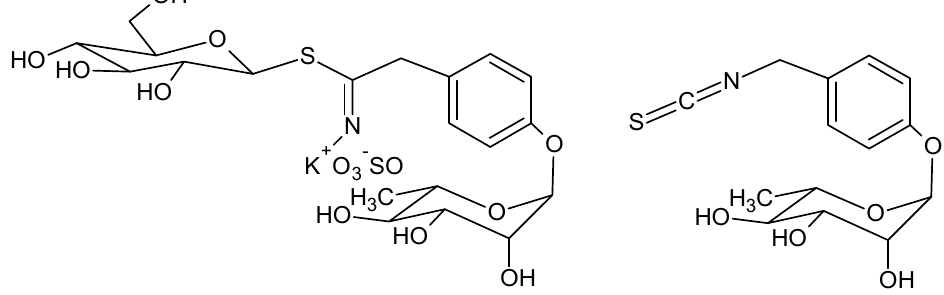
Figure 1. Structure of glucomoringin (left) and moringin (right).